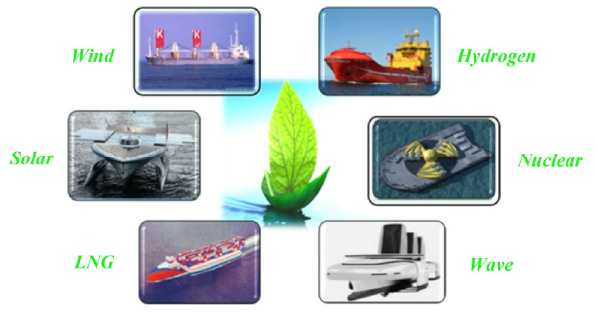
Fig. 3 Green ships that utilize different kinds of new